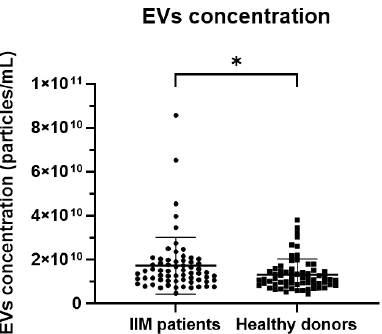
Figure 4. A representative graph of NTA measurement through NanoSight NS300 (Malvern Panalytical) obtained by NTA Software version 3.4, reporting the values of particle concentration in relation to their size. On the left, the three curves show the data captured in three 1 min videos for the same sample. On the right, the merged data ( A ). Graphs representing the EV mean concentration ([EVs/mL] ± SD) ( B ), EV mean size (nm ± SD) ( C ), and EV mode size (nm ± SD) ( D ) (n = 130).